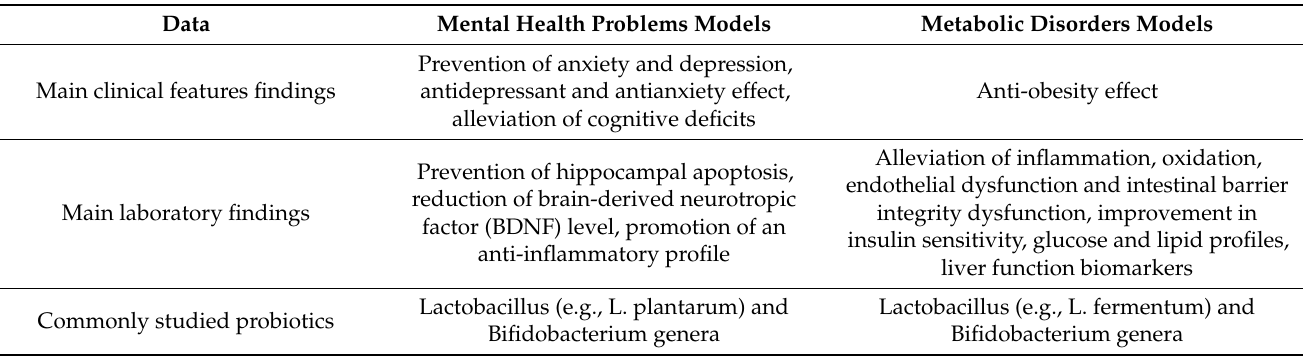
Table 1. Summary of the most important data from pre-clinical studies on probiotics in some mental health and metabolic disorders